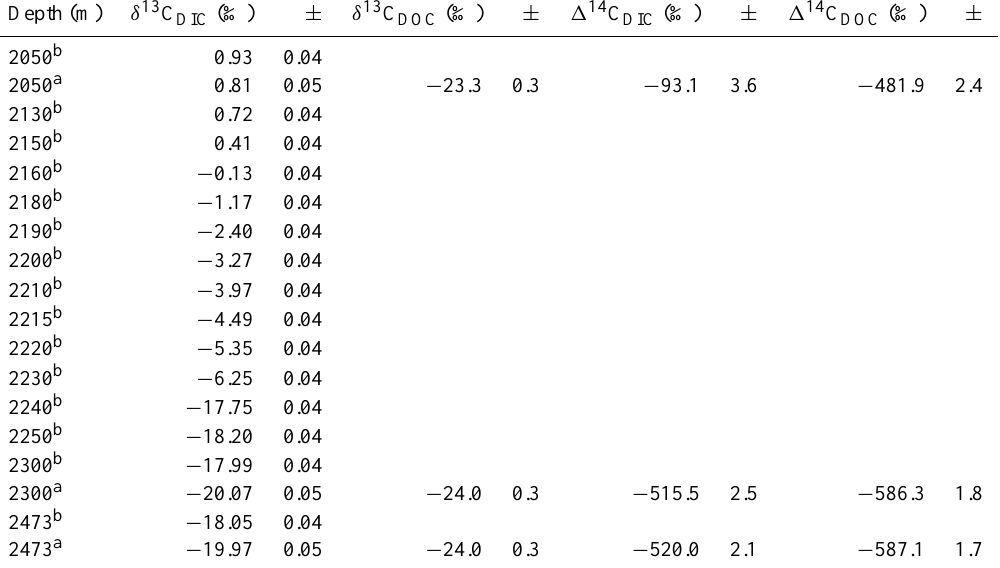
Table 1. Isotopic composition of Orca Basin brine and overlying